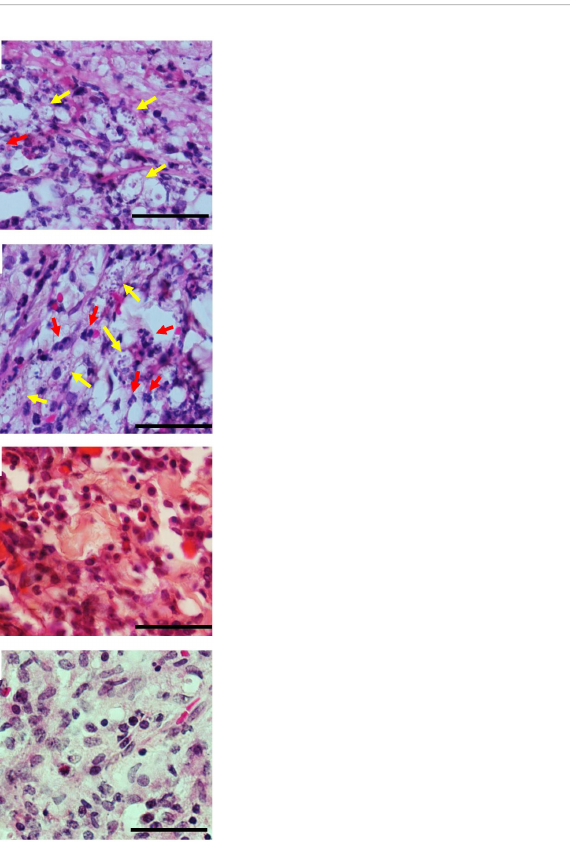
FIGURE 5 Histopathological aspects of lesions of infected hamsters treated with 3-PL. Golden hamsters (n = 4) infected in the dorsal hind paw with L. ( V. ) braziliensis were treated with 3-PL or reference drug Glucantime ® from one week of infection for two weeks and histological analysis of the lesions was performed by H&E staining. (A) Uninfected; (B) Infected untreated; (C) DMSO sc; (D) DMSO tattoo; (E) 3-PL sc; (F) 3-PL tattoo; (G) Glucantime ® sc; (H) Glucantime ® tattoo. Data show representative pictures of each group. Yellow arrow: intracellular amastigotes; Red arrow: neutrophils. 1000x magni fi cation, scale bar = 25